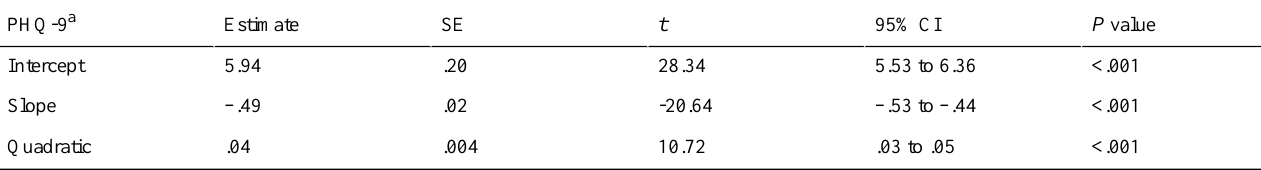
Table 1. Unconditional growth model for depression